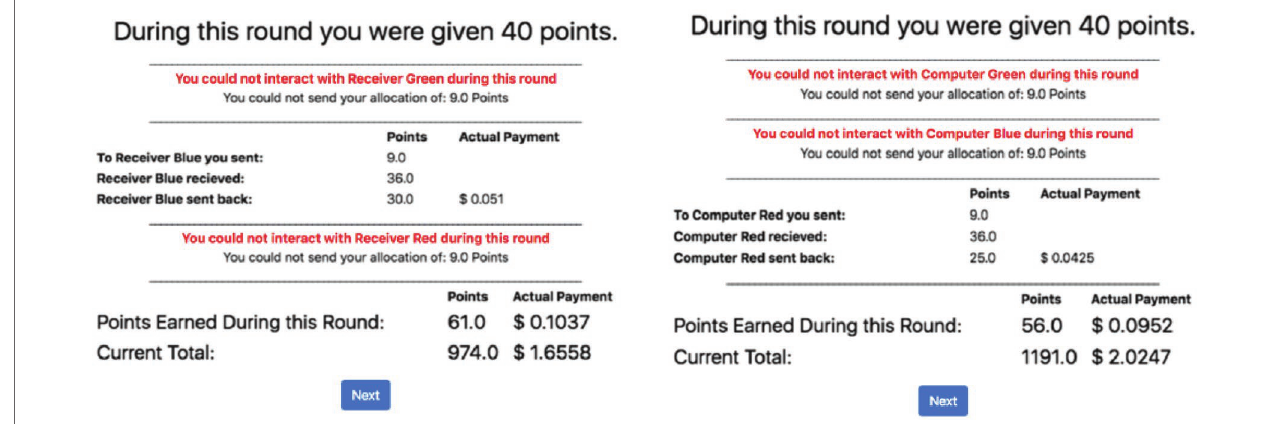
FIGURE 1 | An example of the results page in the multi-arm trust game (MATG) shown to participants in the animacy condition (left plot) and the inanimacy condition (right